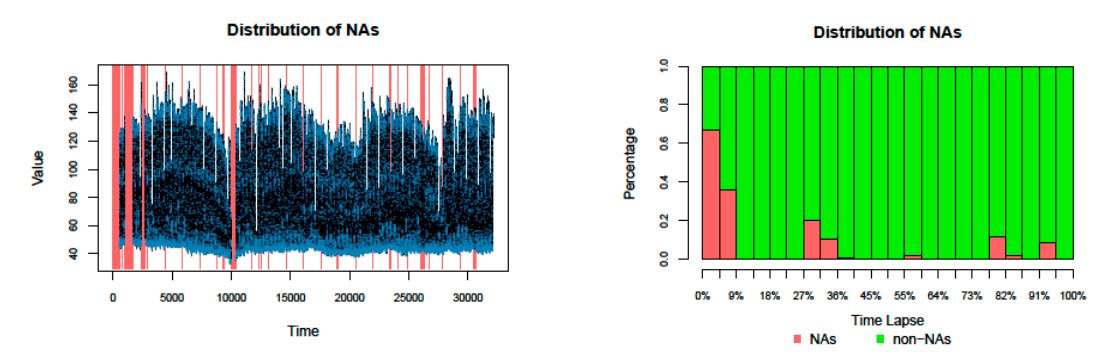
Figure 4. Missing data statistics for energy consumption data.